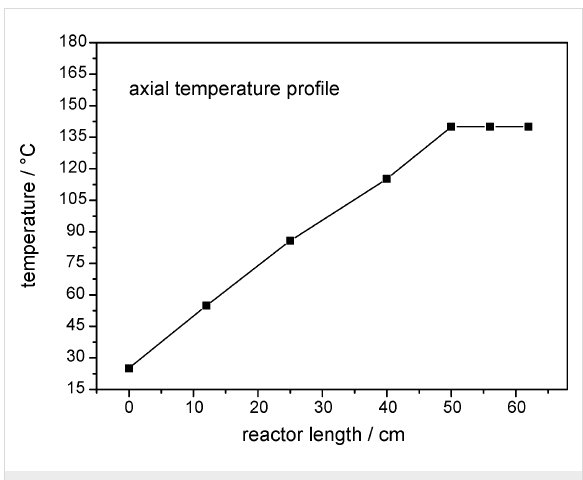
Figure 2: Measured temperature profile along the tubular reactor.